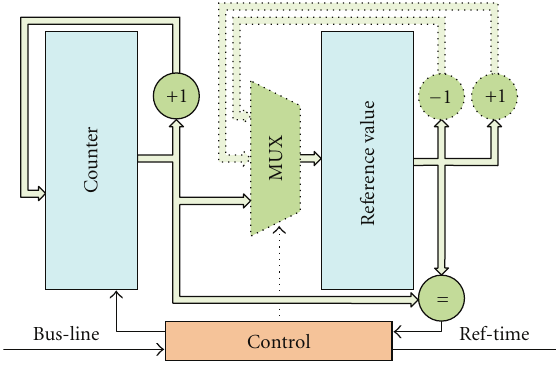
Figure 10: Basic structure of the timer-reference generation circuit.